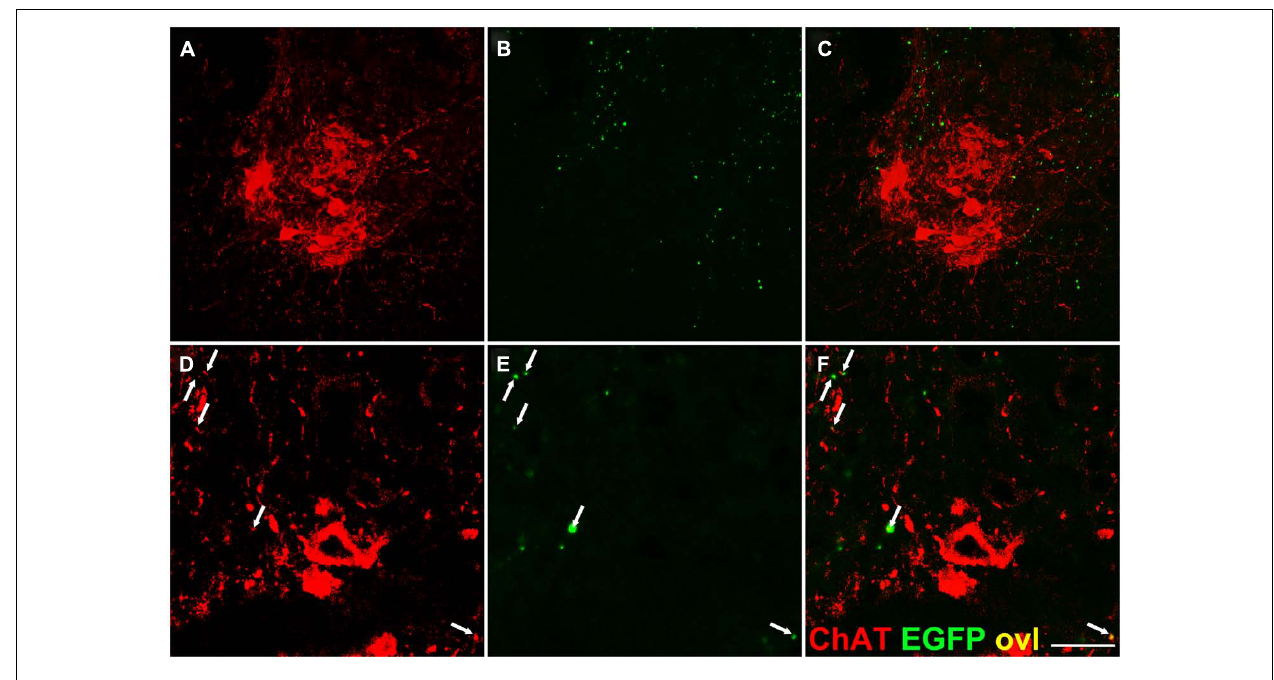
FIGURE 6 | Infrequent EGFP+ puncta in the proximity of lamina IX motor neuron somata. Transverse sections of the spinal cord gray matter at the cervical level, lamina IX. (A,D) Choline acetyl transferase (ChAT) immunostaining. (B,E) EGFP immunostaining; (C,F) overlay.Very few